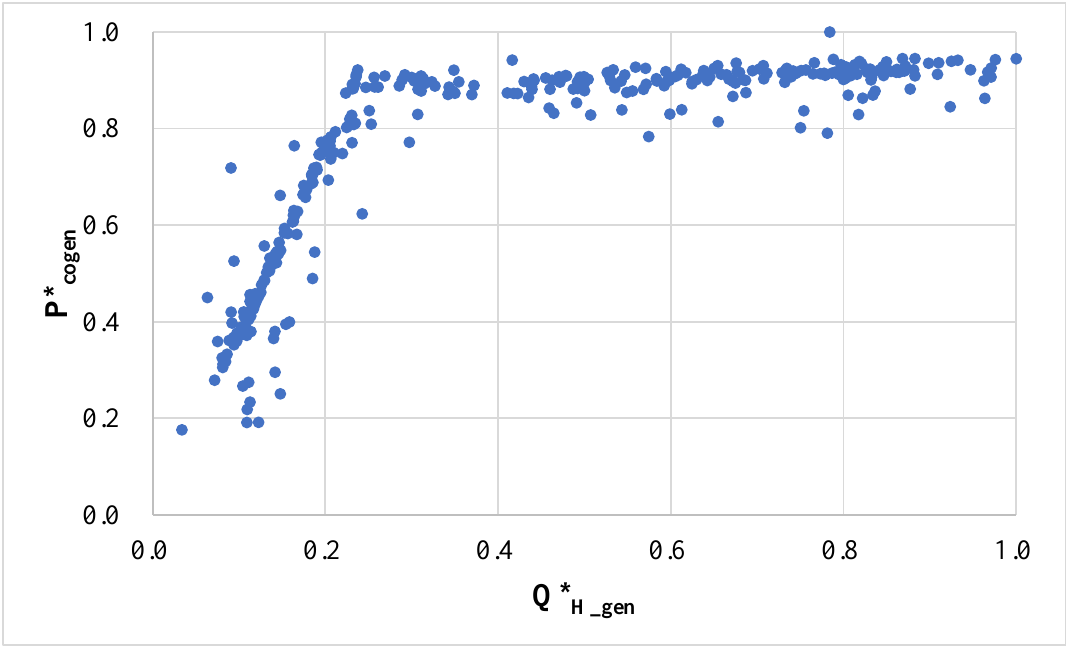
Figure 10. Comparison of the simulated operational cost–benefit for each scenario with the installation costs of the cogeneration system in Case A.